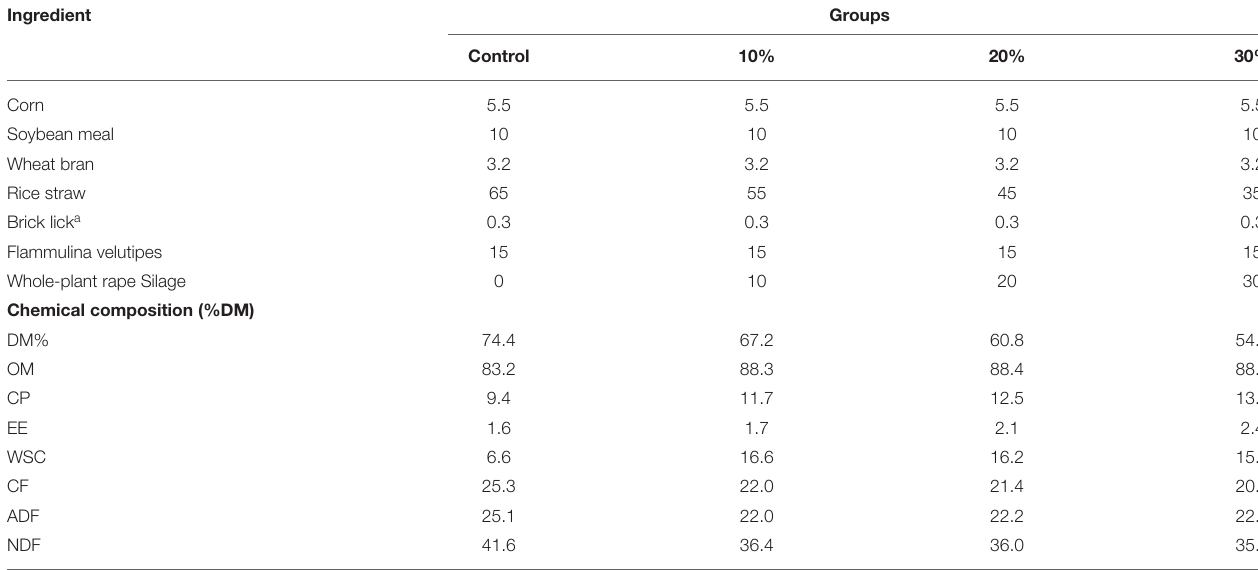
TABLE 4 | Experimental diet content and composition (DM basis). Ingredient